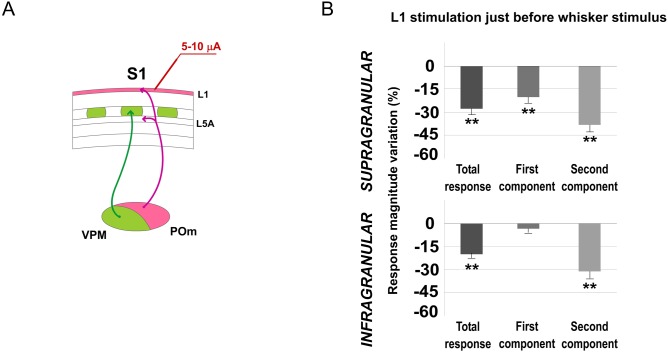
L1 E-stimulation before sensory stimulus modulates cortical responses.(A) Schematic diagram indicating the experimental manipulation of the barrel cortex L1. (B) Mean response magnitude variation (%) by L1 E-stimulation is quantified in this Fig Magnitude reduction was more prevalent in the second component of the response in both layers. In infragranular layers, in the first component we did not find a significant decrease of spikes. However, spikes in the second component were decreased strongly by L1 E-stimulation. In supragranular layers, in both components we found a significant reduction of spikes.